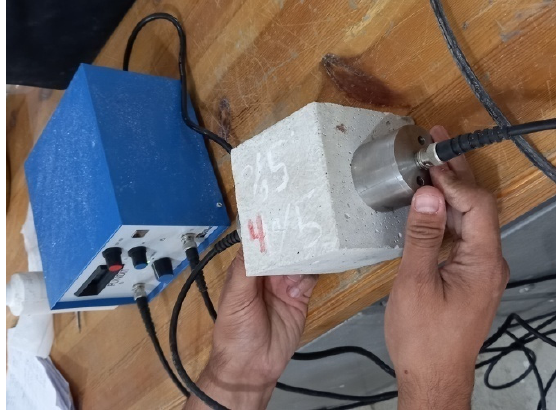
Figure 3. Ultrasonic pulse velocity test setup.